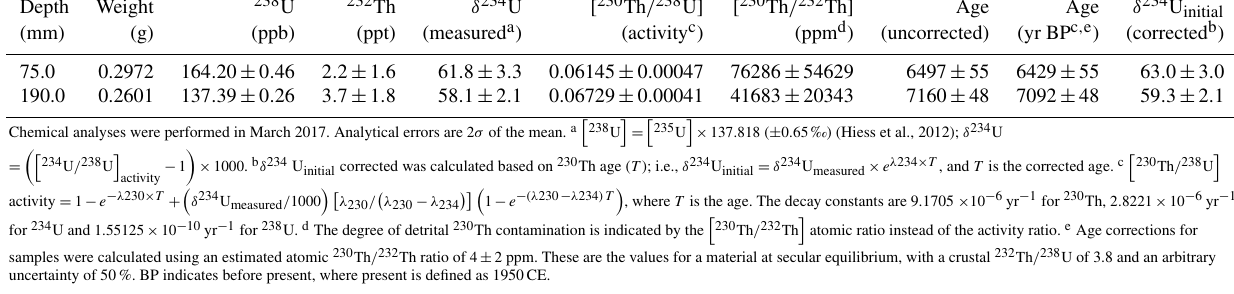
Table 3. Thorium-230 dating results of stalagmite HSN1 from Hoshino Cave. Depth